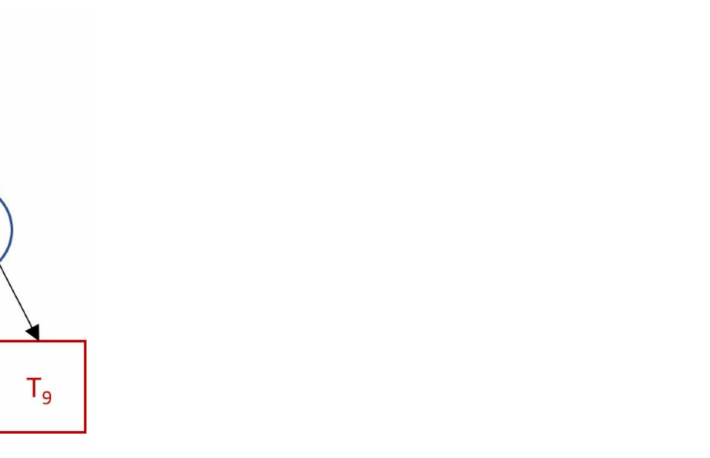
Figure 16. Task decomposition diagram for the example MAS. Tasks not shown are assumed to have no dependencies.